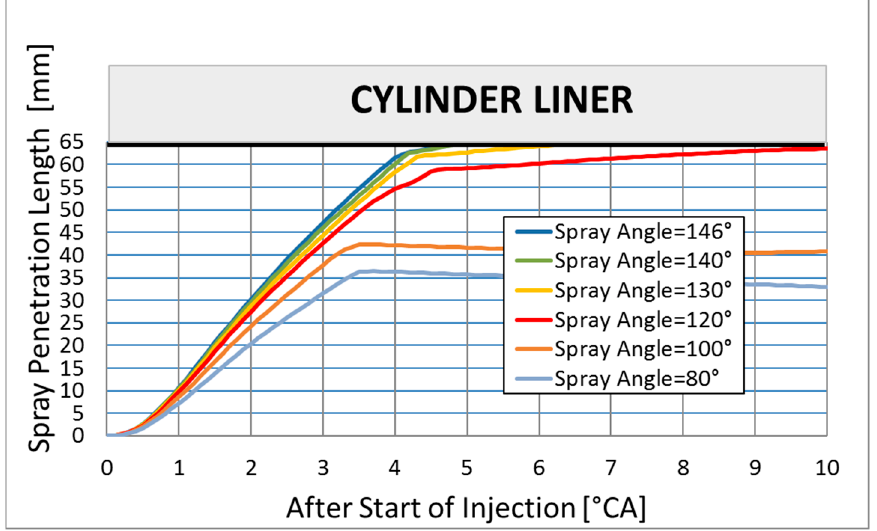
Figure 28. Effect of SIA on STPL in radial direction history for an ESI with SOI of − 50 ◦ CA ATDC. For various SIAs of 140 ◦ , 130 ◦ , 120 ◦ , 100 ◦ , and 80 ◦ , the evolution of spray penetration in oblique side and top views, as well as RER contour plots in a plane through the axes of the cylinder and a spray, in the instants of 5, 10, 15, and 20 ◦ CA after SOI, are presented in Figures 29–33, respectively. For an SIA of 140 ◦ , the fuel sprays impinge on the cylinder liner, forming a rich FVAM near the liner, which becomes lean before auto-ignition. On the other hand, the combustion of rich FVAM that has formed in the crevice in a low-temperature environment increases CO emissions. For an SIA of 130 ◦ case, sprays impinge on the top flat face of the piston, forming a liquid film which then spreads on the cylinder liner. Part of the liquid film rises toward the cylinder head, while the rest penetrates the crevice. Later, rich-mixture zones form below the cylinder head near the cylinder liner and in the crevice as the liquid films evaporate due to the rising combustion chamber temperature. On the other hand, a very lean mixture, which does not auto-ignite, is formed near the soot-in-oil rim region due to partial evaporation of the droplets of the main sprays before they interact with the piston. For an SIA of 120 ◦ , the fuel sprays impinge on the piston squish area and split into two streams, which spread toward the piston bowl and the cylinder liner. The upper portion partly rises toward the cylinder head along the liner and partly drains down to the crevice between the cylinder liner and piston after hitting the liner, while the lower branch enters the piston bowl, where it mixes and reacts with swirling turbulent air. In the case of an SIA of 100 ◦ , the spray impinges on the tip of the soot-in-oil rim, splitting into two branches. Part of the upper stream impinges on a valve after being deflected by the vertical face between the soot-in-oil rim and the piston squish area and partly spills over the piston squish area, while the rest enters the piston bowl, flows in a tumbling motion in a clockwise direction in the re-entrant region, and mixes with the air inside the piston bowl. Spray-targeting the edge of the piston bowl promotes mixing prior to auto-ignition and reduces CO emissions [17]. Moreover, narrow SIA results in shorter STPL, which reduces soot emissions due to enhanced FVAM formation. In the case of 80 ◦ SIA, the fuel spray impinges on the curved part of the piston bowl and splits into two branches, both of which remain inside the piston bowl due to the clockwise tumbling motion of the air, forming a large, rich FVAM zone. Therefore, spray impingement on the cylinder liner is prevented by narrow SIAs for ESI